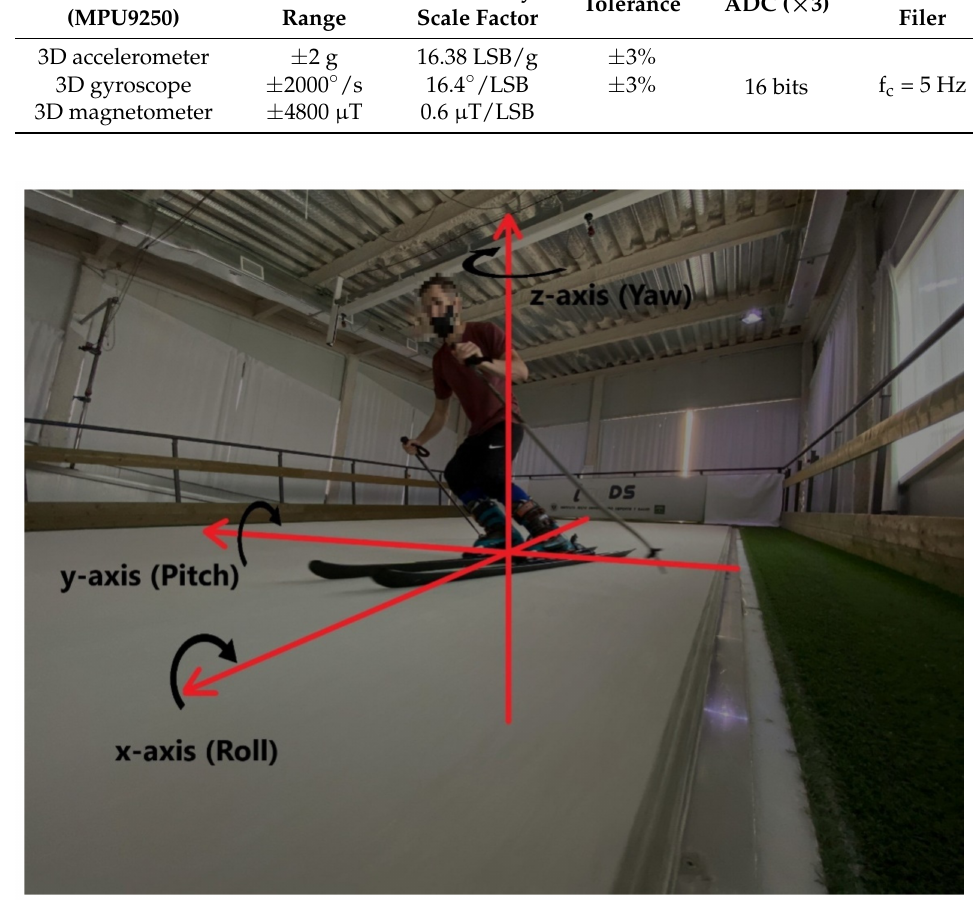
Figure 2. Rotational axes of the ski